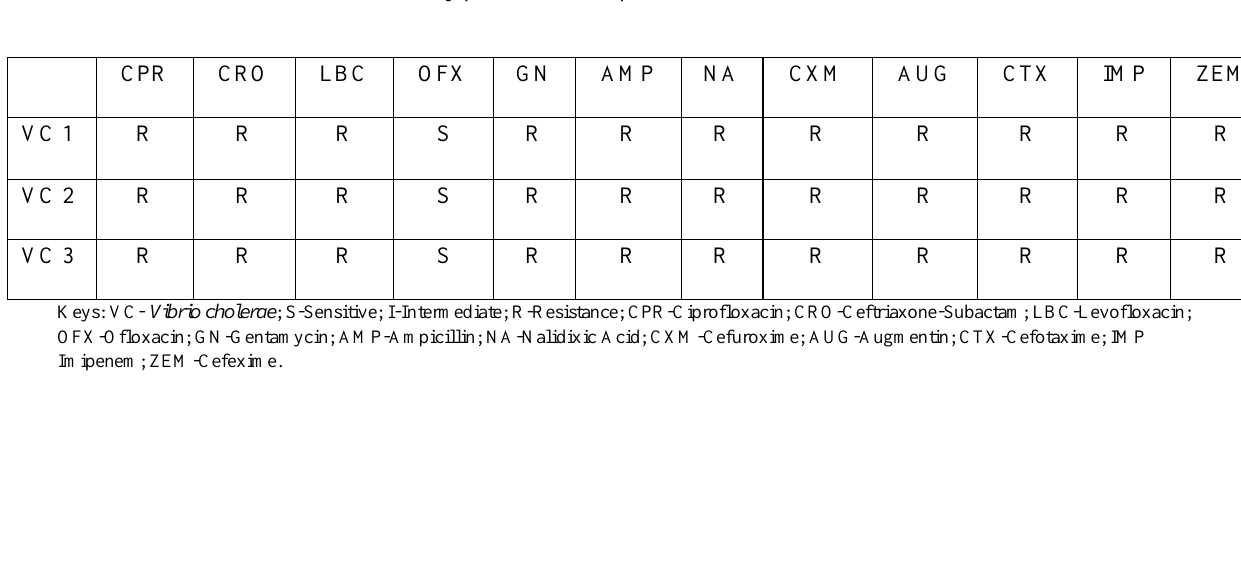
Table 3. Deduced antibiotics sensitivity pattern of multiple antibiotic resistant Vibrio cholerae.